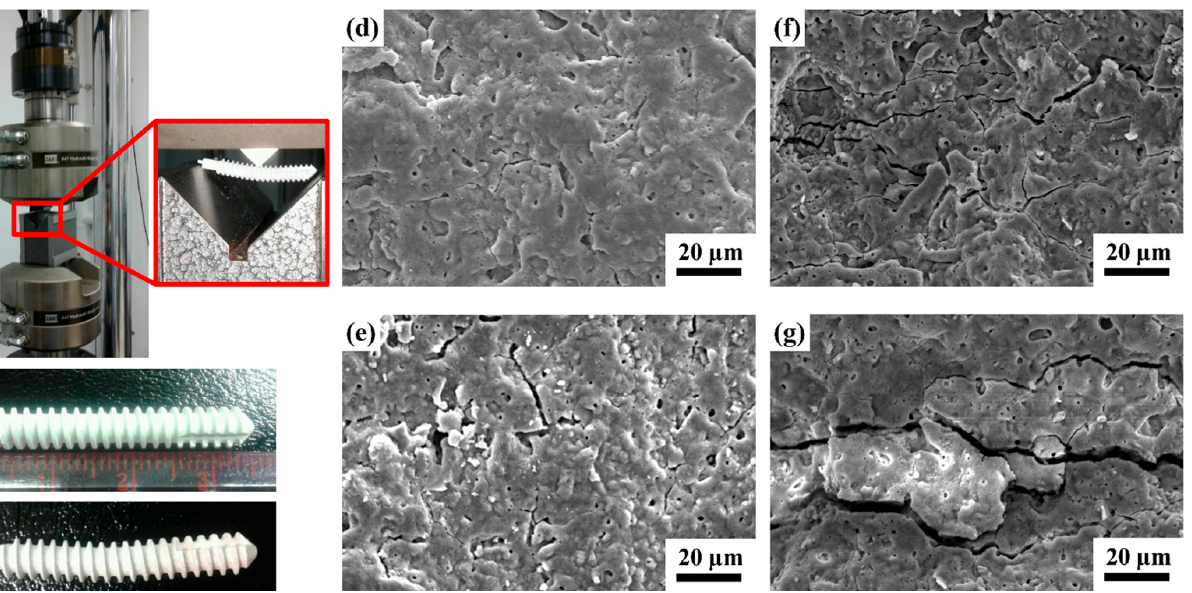
Table 3. Three-point bending measurement of the ZK60 Mg alloy bone screws treated with MAOCa.